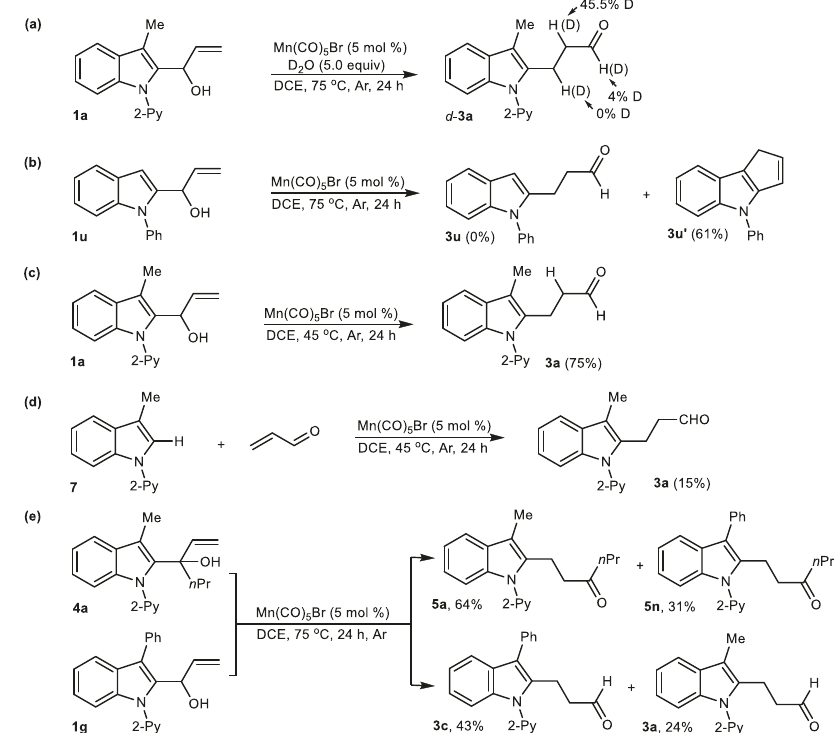
Fig.6|Preliminarymechanismstudies.a H/Dexchangeexperiment. b Intramolecularcyclizationof α -[2-( N -phenyl)indolyl]allylic-alcohol. c Csp 2 -Csp 3 σ bondactivation-